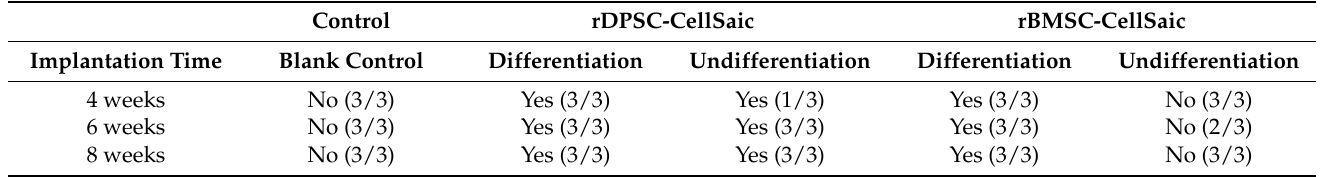
Table 1. Summary of bone formation in rat congenital cleft-jaw model ( n = 3). Control